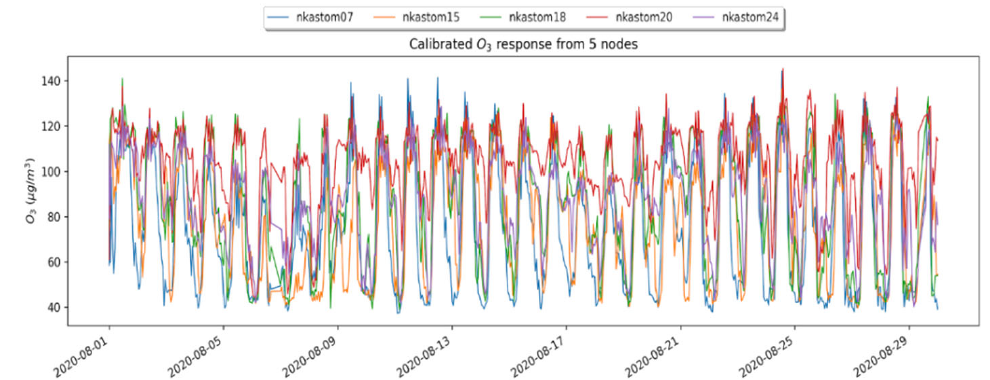
Figure 14. Calibrated response from 5 PM 10 LCS not involved in the training. nkastom## refers to the code id of the node.